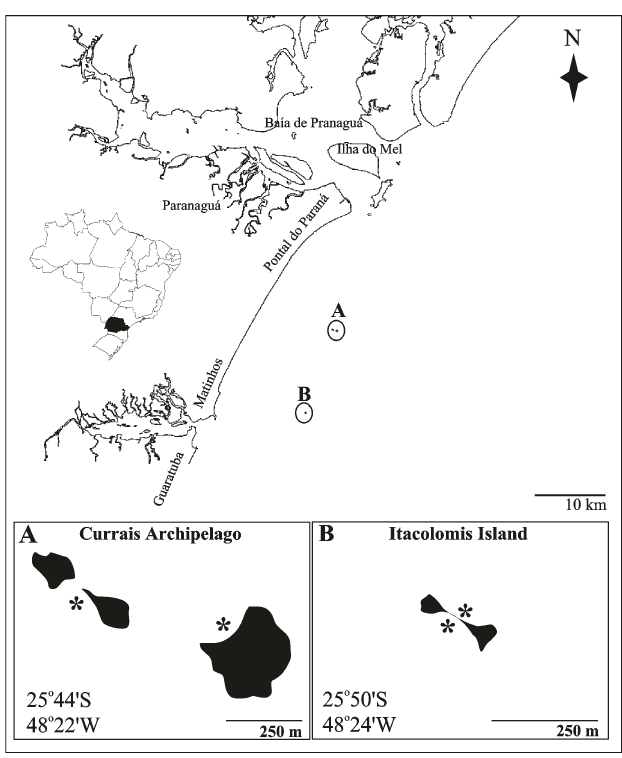
Paraná coast. (A) Currais Archipelago and (B) Itacolomis